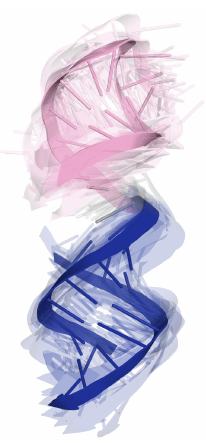
Figure 9. HVR hairpin (light purple) and HVR stem (blue) domains in coaxial